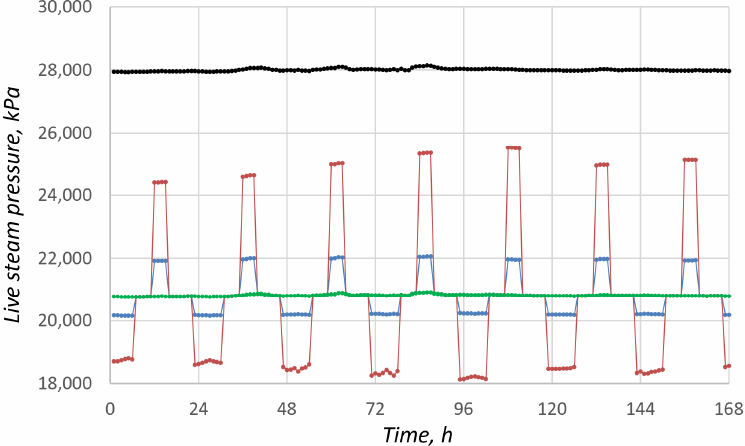
Figure 7. Live steam pressure as a function of time for first week of reference year (black—REF_3NR, green—REF_2NR, blue—TES25 (200 MWh), and red—TES150 (1200 MWh)).